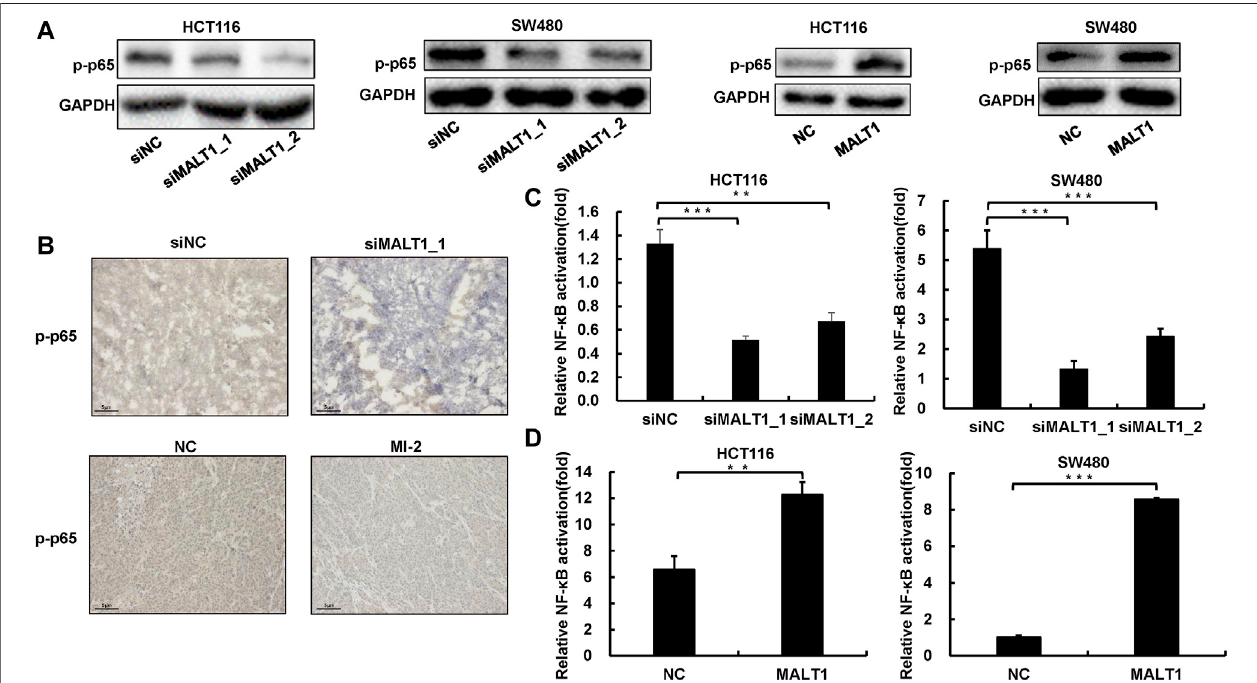
FIGURE 5 | Loss of MALT1 impaired NF- κ B pathway activation. (A) The protein level of p-p65 in CRC cells transfected, as described, was determined by immunoblotting. (B) Representative IHC images of p-p65 on tumor sections. Dual-luciferase reporter assays were used to analyze NF- κ B activation in CRC cells (C,D) . Each experiment wasperformedin triplicate, and data arepresentedasmean ±SD. One-way ANOVA and Dunnett ’ smultiple comparison test were used toanalyze the data (* p < 0.05, ** p < 0.01, *** p < 0.001).